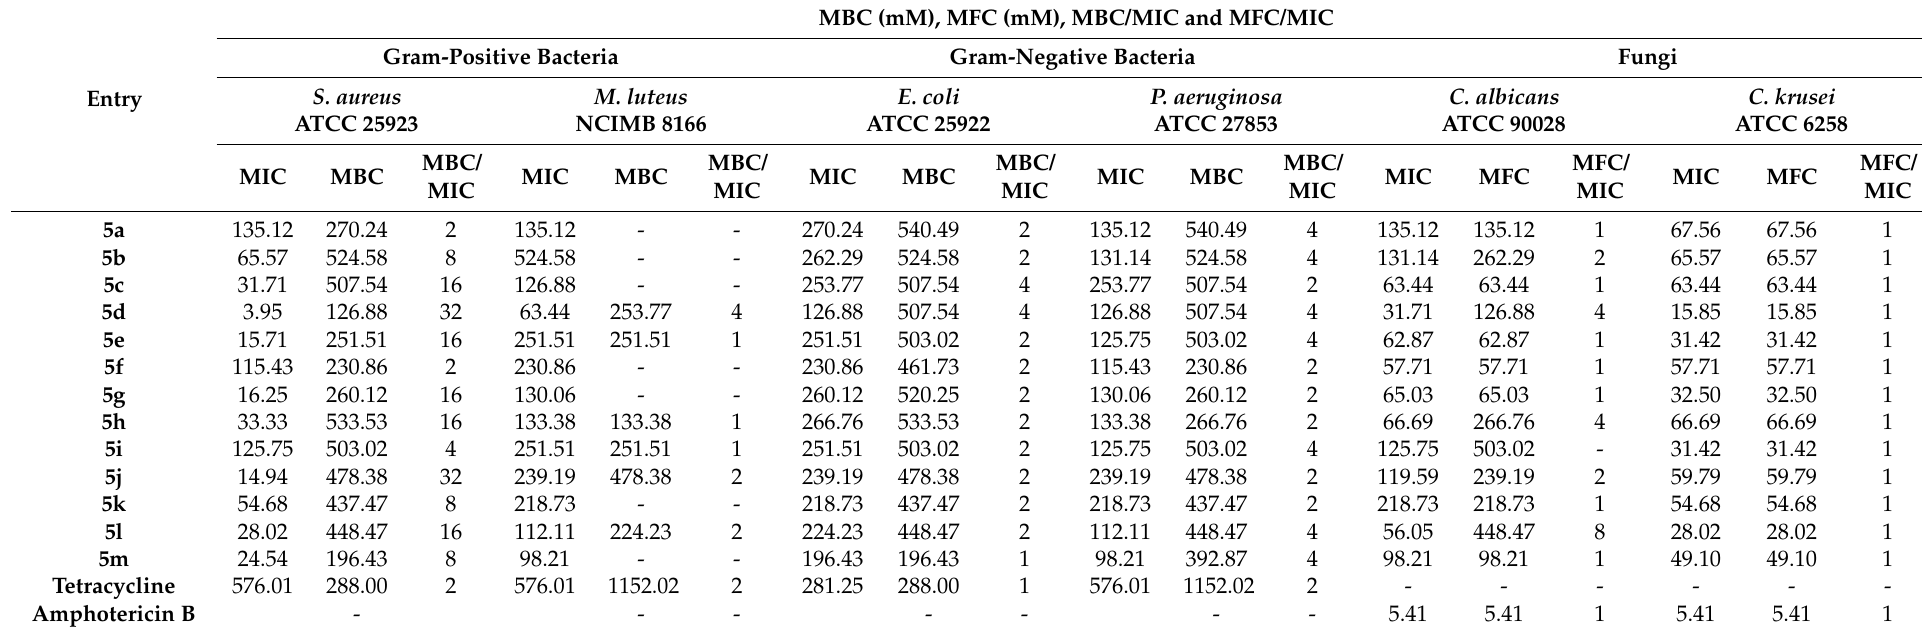
Table 2. MIC, MBC, MFC, MBC/MIC and MFC/MIC of the synthesized compounds against the tested pathogenic